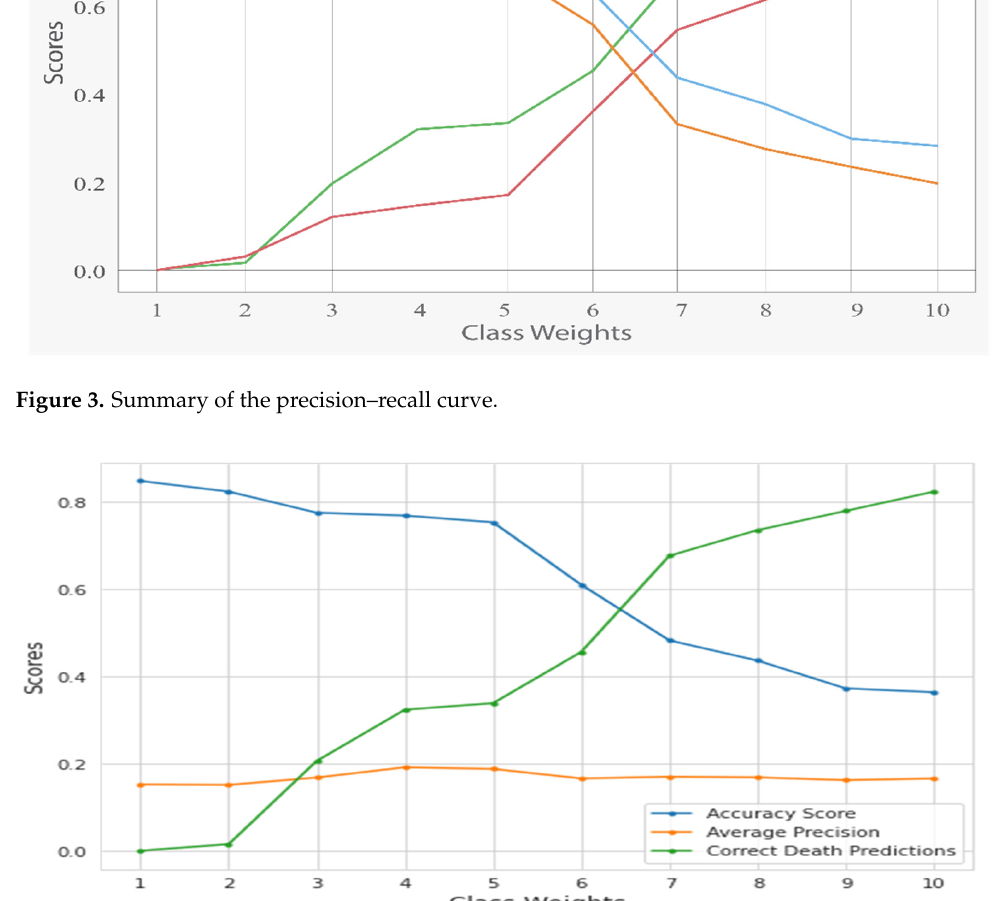
Figure 4. Summary of the accuracy score curve with balanced weights.